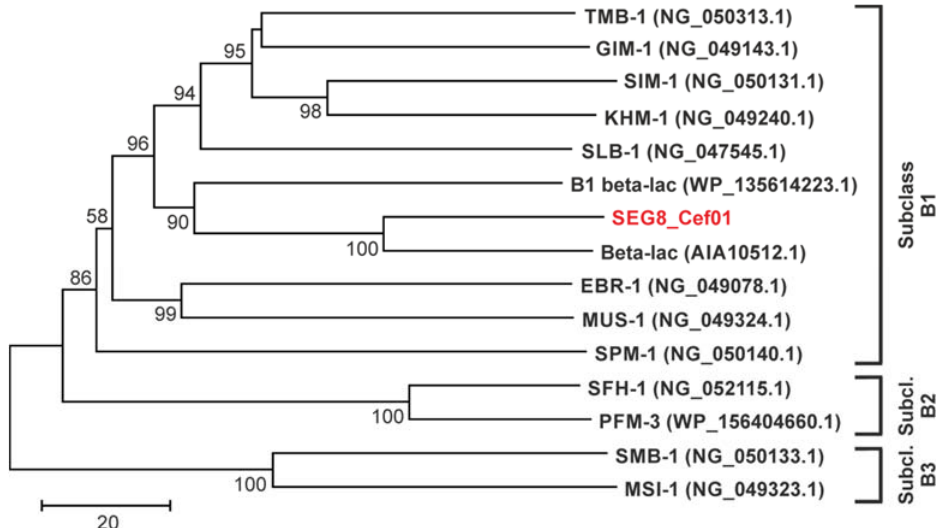
Figure 2. Neighbor-joining phylogenetic tree based on amino acid sequences of SEG8_Cef01 and other metallo-beta-lactamases. Besides SEG8_Cef01, its closest related reference database entry, and different representatives of subclasses B1, B2 and B3 were considered. Bootstrap values ≥ 50, based on 1000 iterations, are shown at branching points. Accession numbers of the different beta-lactamases are given in parentheses. Abbreviations: Subcl., Subclass; Beta-lac, Beta-lactamase.